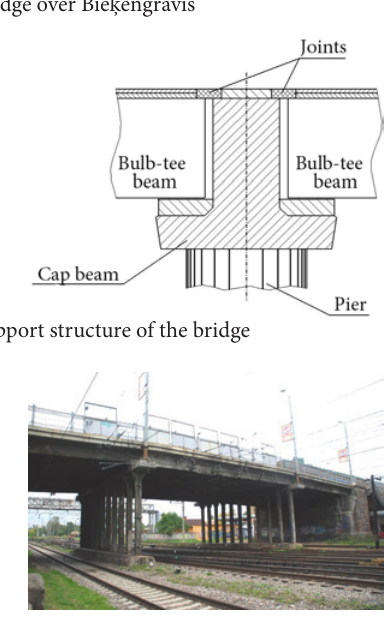
fig. 6. Bridge over the railroad (“Gaisa tilts”) in Riga